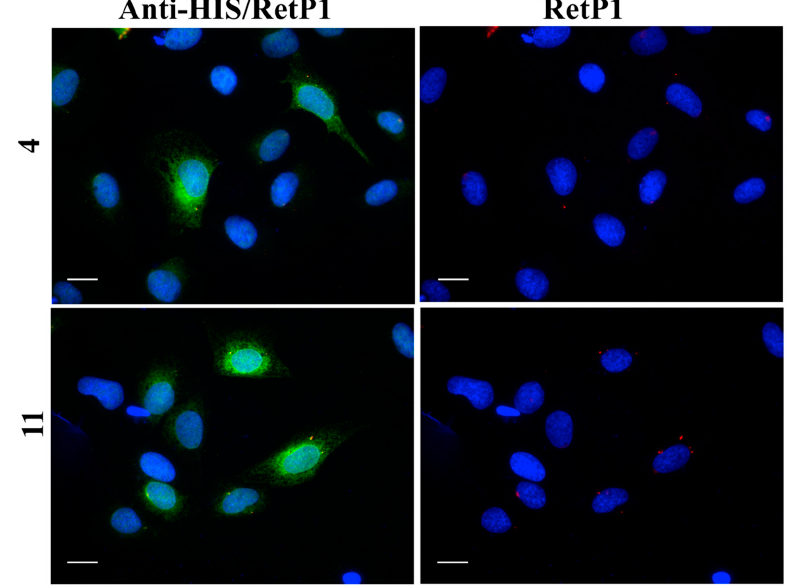
Figure 18. Subcellular localisation of hRHO P23H His-Tag in the presence of tested compounds (representative images): 4 and 11. 4 were tested at 20 µM, whereas 11 at 10 µM Anti-His/RetP1: merged image of RetP1 staining (red) and Anti-His Tag binding total rhodopsin staining (His Tag expressed at the C-terminus of rhodopsin, intracellular, post-permeabilisation with 0.1% Triton; green). RetP1: anti-rhodopsin antibody (extracellular N-terminus antibody, incubation prior permeabilisation, red) staining only the protein exposed on the cell membrane. Nuclei were stained with DAPI (blue). Scale bars: 10 µm.